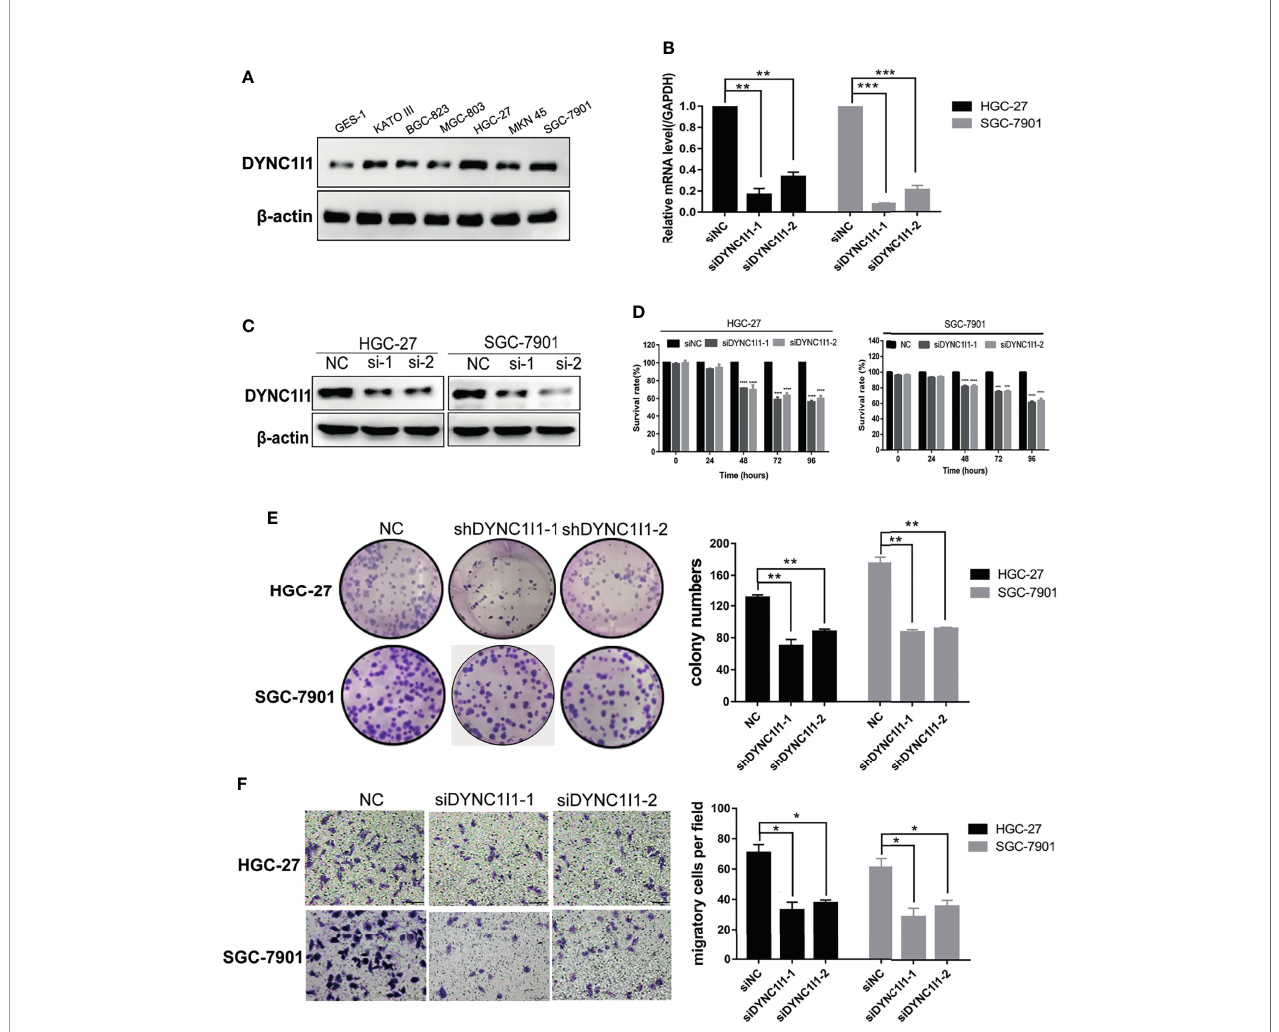
FIGURE 2 | Knockdown of DYNC1I1 leads to suppression of gastric cancer progression and migration in vitro . (A) Western blot shows DYNC1I1 protein expression levels in normal gastric cells and different gastric cancer cells. (B, C) RT-qPCR and western blot show DYNC1I1 transcription level and protein expression after transient knockdown DYNC1I1 gene by using siRNAs for 48 h. (D) MTT shows cell viability of gastric cancer cells after knocking down DYNC1I1 for 0, 24, 48, 72, 96 h. (E) Colony formation shows gastric cancer cells form colony ability after knocking down DYNC1I1. (F) Transwell assay displays the change in migration of gastric cancer cells after knocking down DYNC1I1 or not (magni fi cation × 200). (* P < 0.05, ** P < 0.01,*** P < 0.001, **** P < 0.0001, n = 3, student t -test, means ± 95%